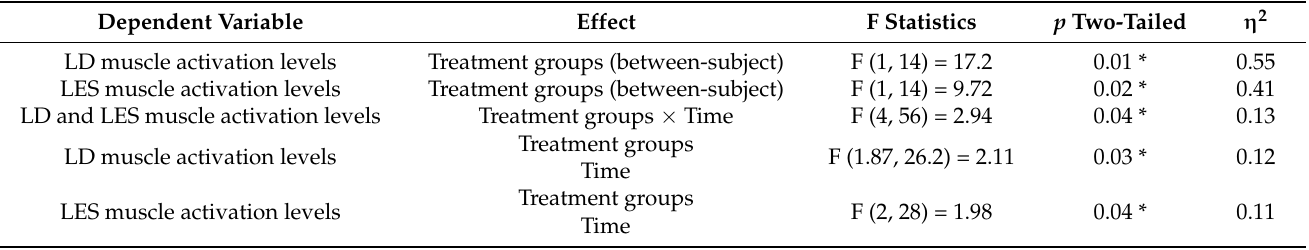
Table 10. Mixed-design repeated measures ANOVA test results with partial squatting posture (35 ◦ eccentric squat